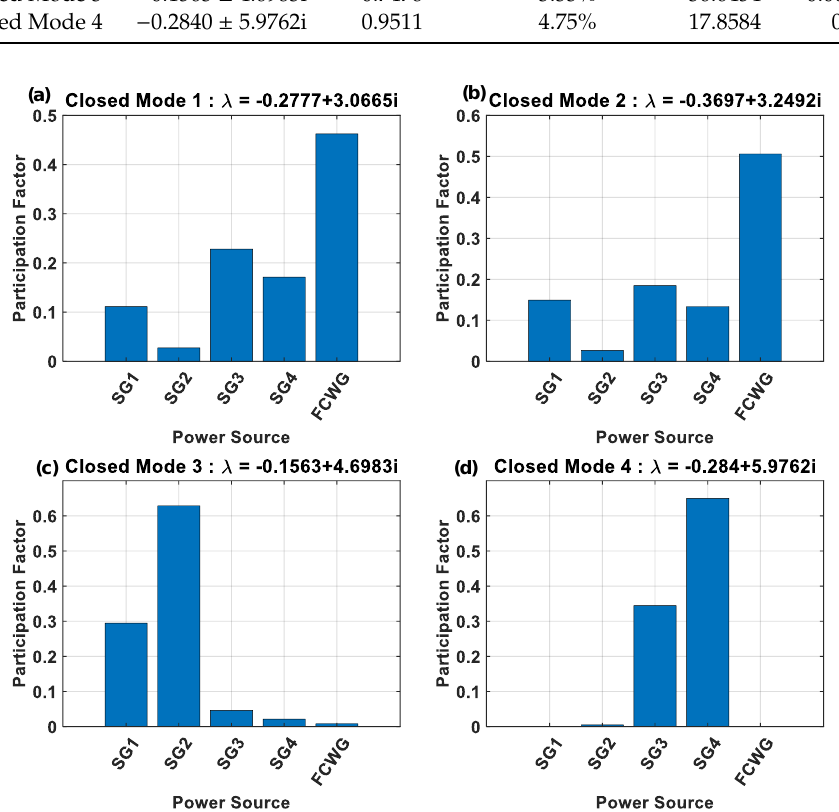
Figure 12. The participation of power sources in major oscillation modes of the closed-loop power system: ( a ) closed-loop Mode 1; ( b ) closed-loop Mode 2; ( c ) closed-loop Mode 3; ( d ) closed-loop Mode 4.